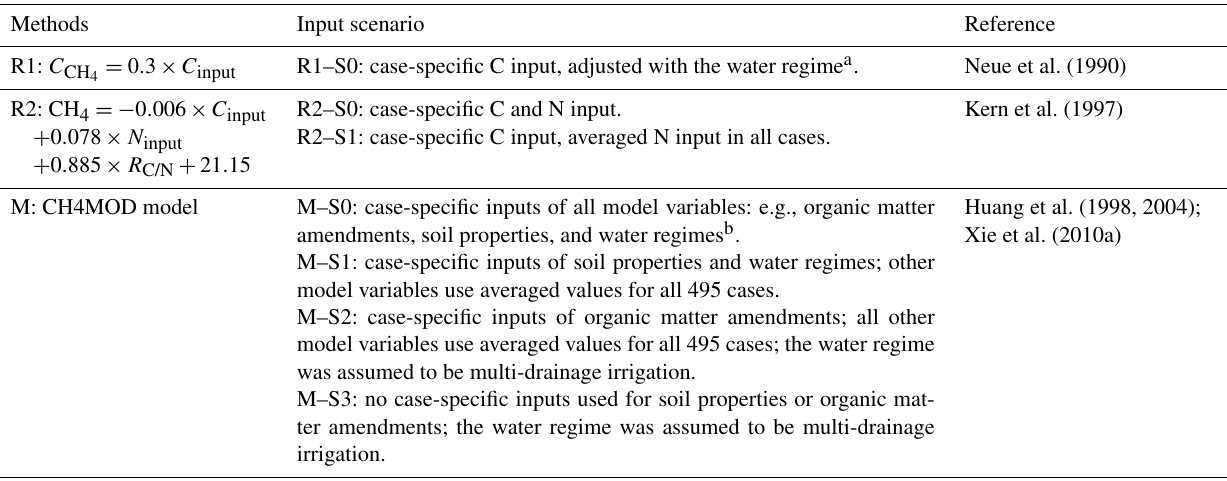
Table 1. Methods and their input scenarios. Methods